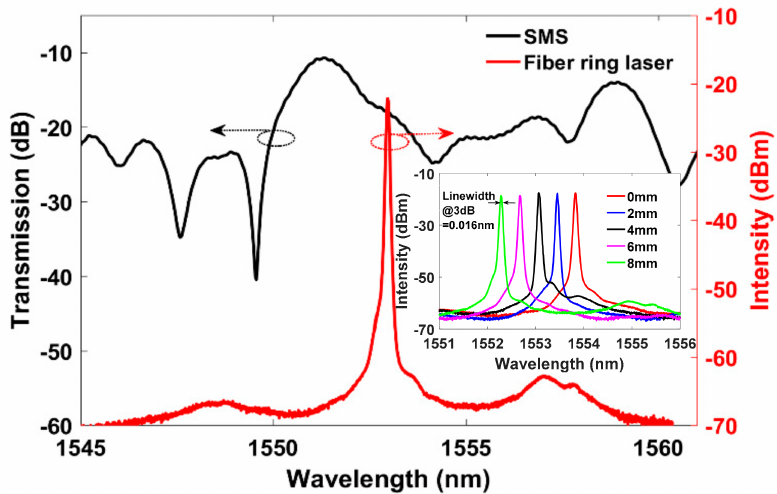
Figure 2. Measured SMS transmission spectrum (black curve) and the laser output spectrum when the SMS sensor inserted into the laser cavity (red